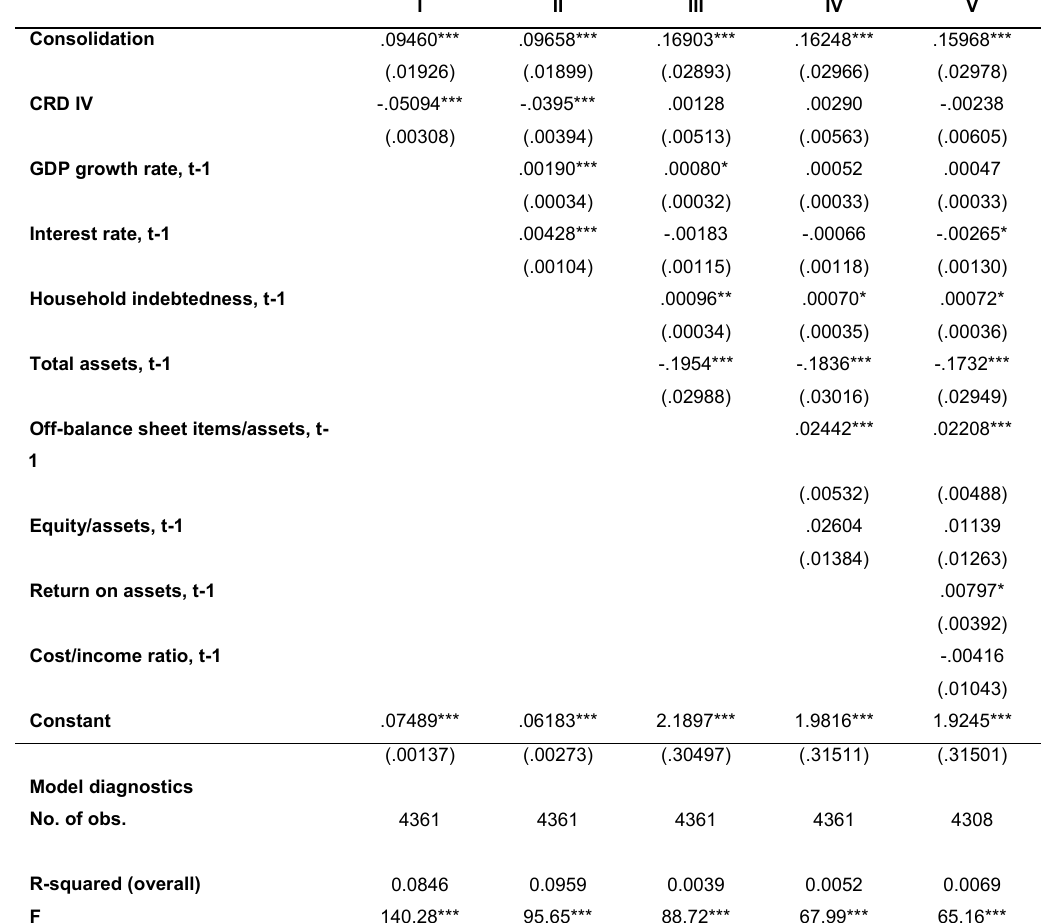
Table 4. Fixed effects